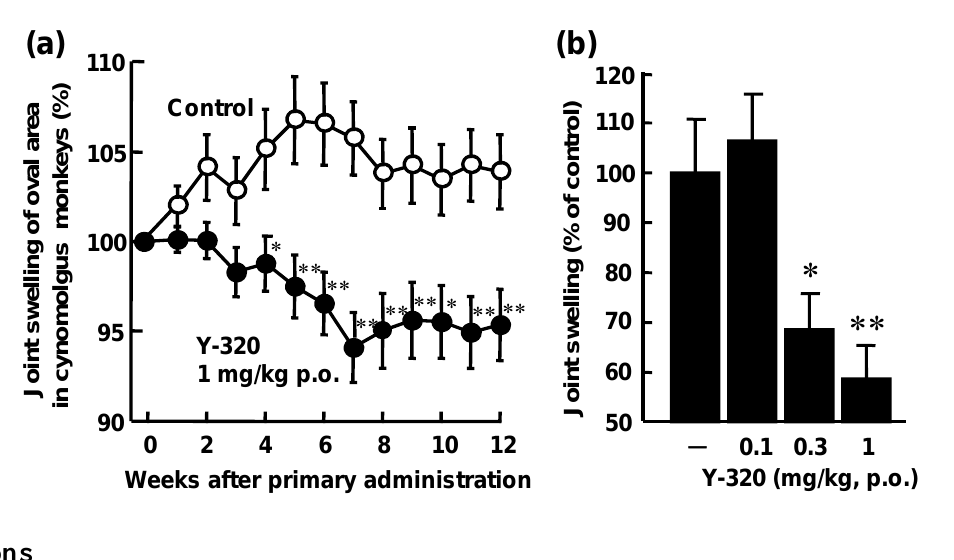
Figure 6. Therapeutic administration of Y-320 ameliorates CIA in cynomolgus monkeys. Y-320 was administered orally to monkeys from 9-week after primary immunization for 12 weeks. ( a ) Y-320 at 1 mg/kg showed a significant reduction of joint swelling; ( b ) Y-320 (0.3 and 1 mg/kg) showed a significant and dose-dependent inhibition of joint swelling. Results were expressed as the mean ± SEM of 12 monkeys. * p < 0.05, ** p <